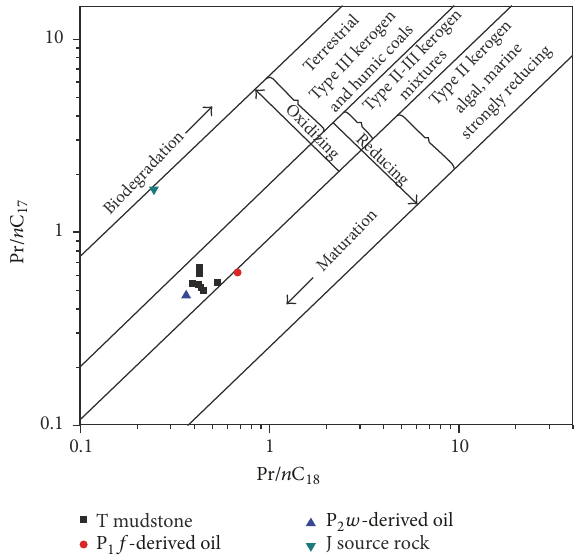
Figure 4: Ph/ n -C 18 versus Pr/ n -C 17 of the Triassic mudstone source rocks collected in this study. Average values of Permian-derived oils and Jurassic mudstone source rocks are plotted for